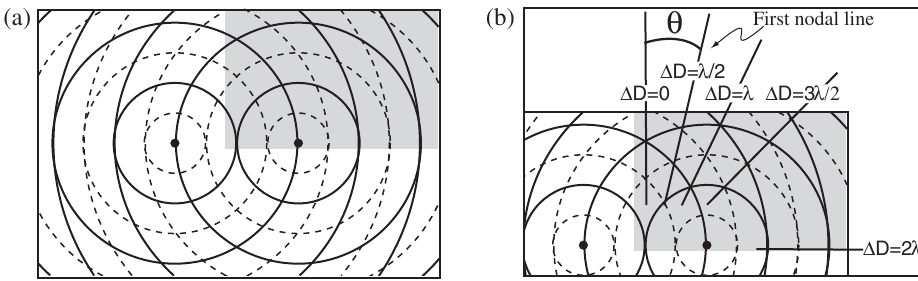
FIG. 1. (a) Diagram shown to students in the two-source interference problem. As part of the problem, students determine the number of nodal lines and lines of maximum constructive interference in the shaded region and the angle (cid:4) at which the first nodal line occurs in the region far away from the sources. (b) Diagram showing the features to be identified by